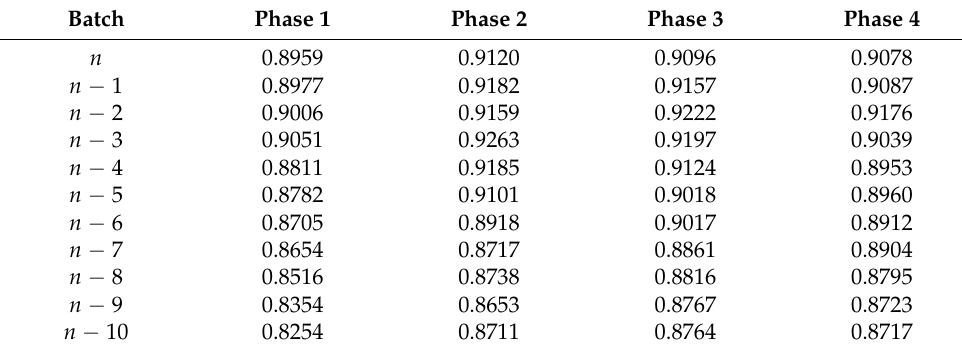
Table 3. Average R 2 c , n of each batch and each phase of mode